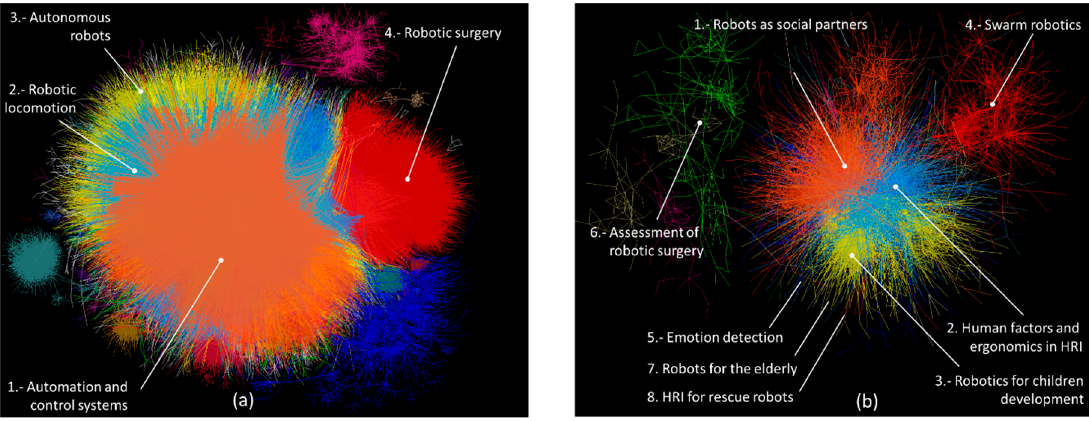
Figure 4. Citation networks of ( a ) robotics research and ( b ) social robotics research. Table 1. Clusters in the robotics network.